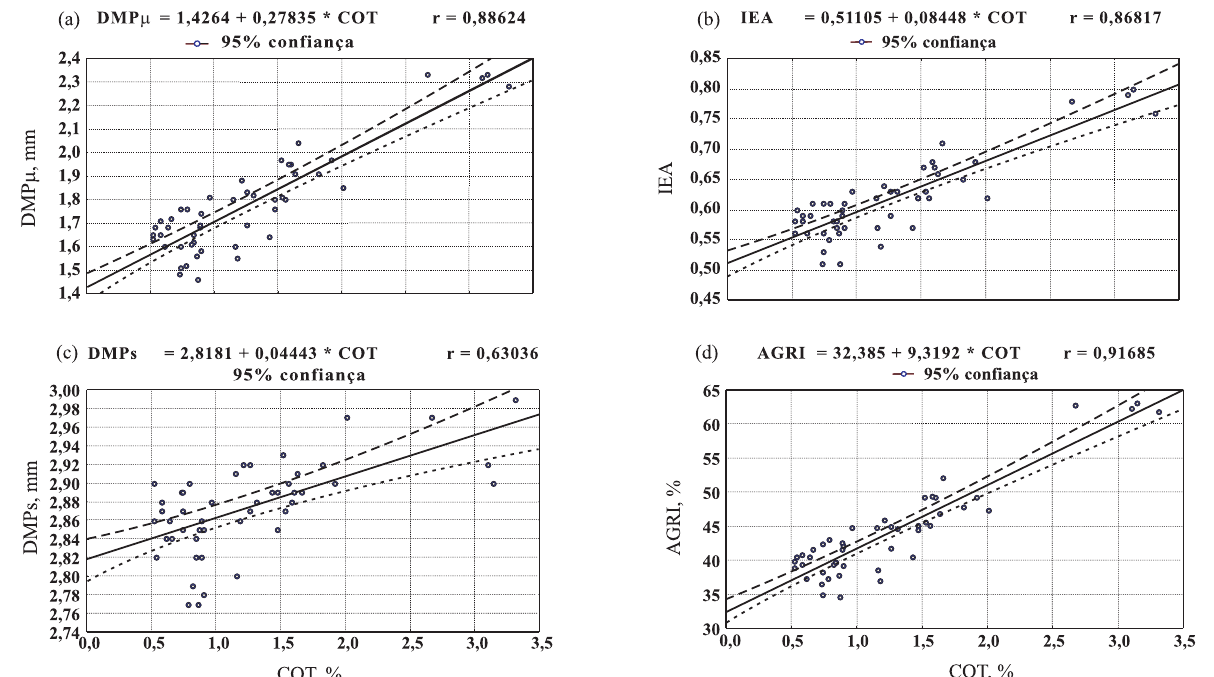
Figura 2. Diâmetro médio ponderado de agregados via úmida (DMP μ ), (a) índice de estabilidade de agregados (IEA), (b) diâmetro médio ponderado de agregados via seca (DMPs), (c) e percentagem de agregados maiores que 2,0 mm estáveis em água (Agri), (d) em função do carbono orgânico total (COT) do solo, para o Latossolo Amarelo